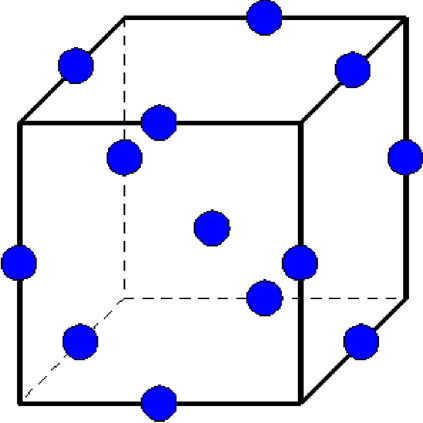
Fig. 7 Box–Behnken design for three factors example (NIST